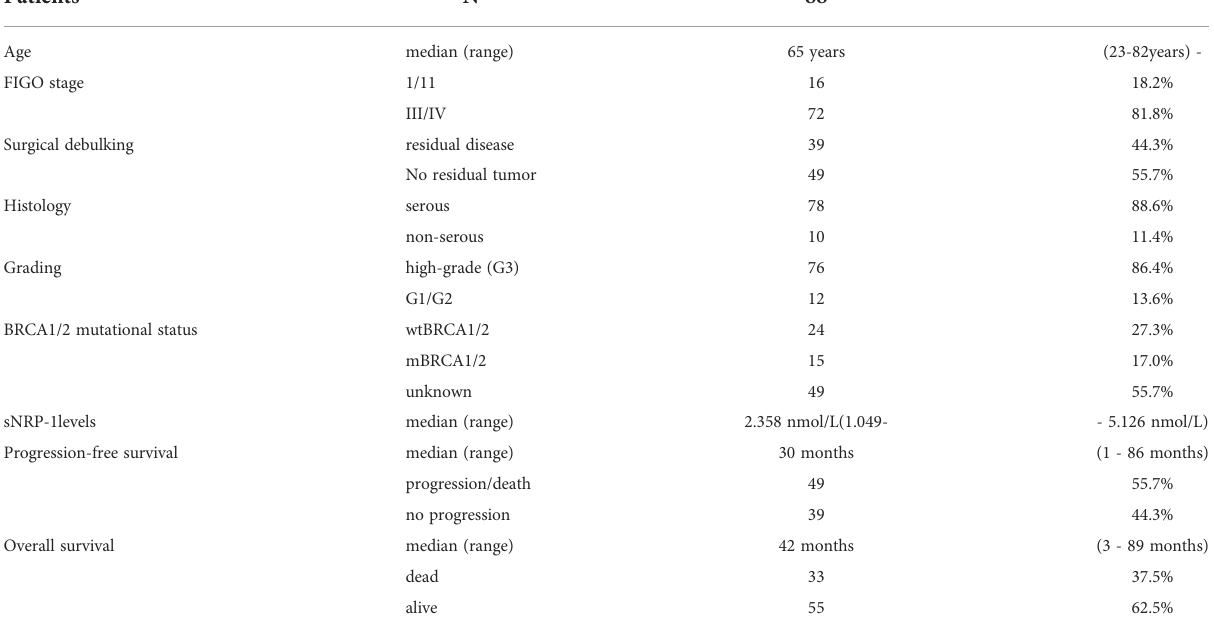
TABLE 1 Patient